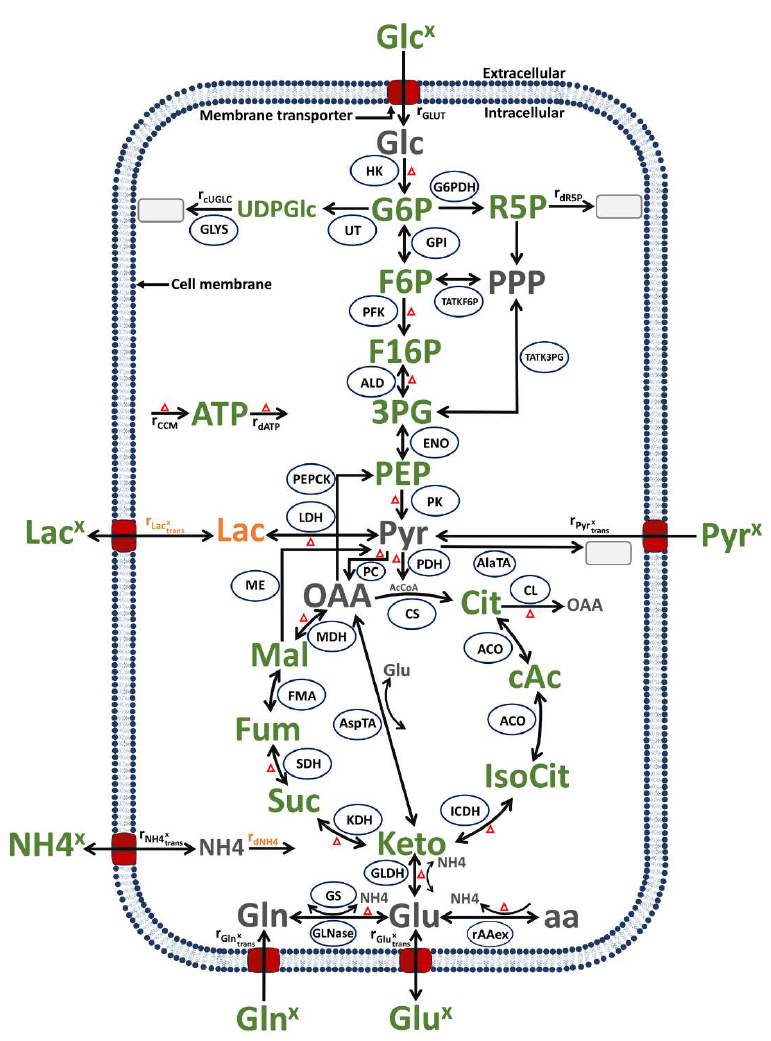
Figure 9. Simplified model of the central carbon and energy metabolism of MDCK cells, modified from [52] (changes to the previous model in orange). In green: metabolites and product measured experimentally; in grey: metabolites not measured. Ellipsoids: enzymes considered in the model. Arrows: reactions or transport, with the arrowhead indicating the reaction or transport direction (for simplification, reversible reactions have an arrow for both directions). Grey rectangles: sinks or metabolites not accounted for in the model. Red triangles: all the reactions included in the energy balance. Abbreviations of metabolites and product : 3PG: 3-phosphoglycerate, AcCoA: acetyl coen- zyme A, ATP: adenosine tri-phosphate, cAc: cis-Aconitate, Cit: citrate, F16P: fructose 1,6-biphos- phate, F6P: fructose-6-phosphate, Fum: fumarate, G6P: glucose-6-phosphate, Glc: glucose (intracel- lular), Glc x : glucose (extracellular), Gln: glutamine (intracellular), Gln x : glutamine (extracellular), Glu: glutamate (intracellular), Glu x : glutamate (extracellular), IsoCit: iso-citrate, Keto: alpha-ke- toglutarate, Lac x : lactate (extracellular), Mal: malate, NH4: ammonium (intracellular), NH4 x : ammo- nium (extracellular), OAA: oxaloacetate, PEP: phosphoenolpyruvate, Pyr: pyruvate (intracellular), Pyr x : pyruvate (extracellular), R5P: ribose-5-phosphate, SUC: succinate, UDPGlc: uridine diphos- phate Glucose. Abbreviations of enzymes and transport rates: HK: hexokinase, G6PDH: glucose-6-